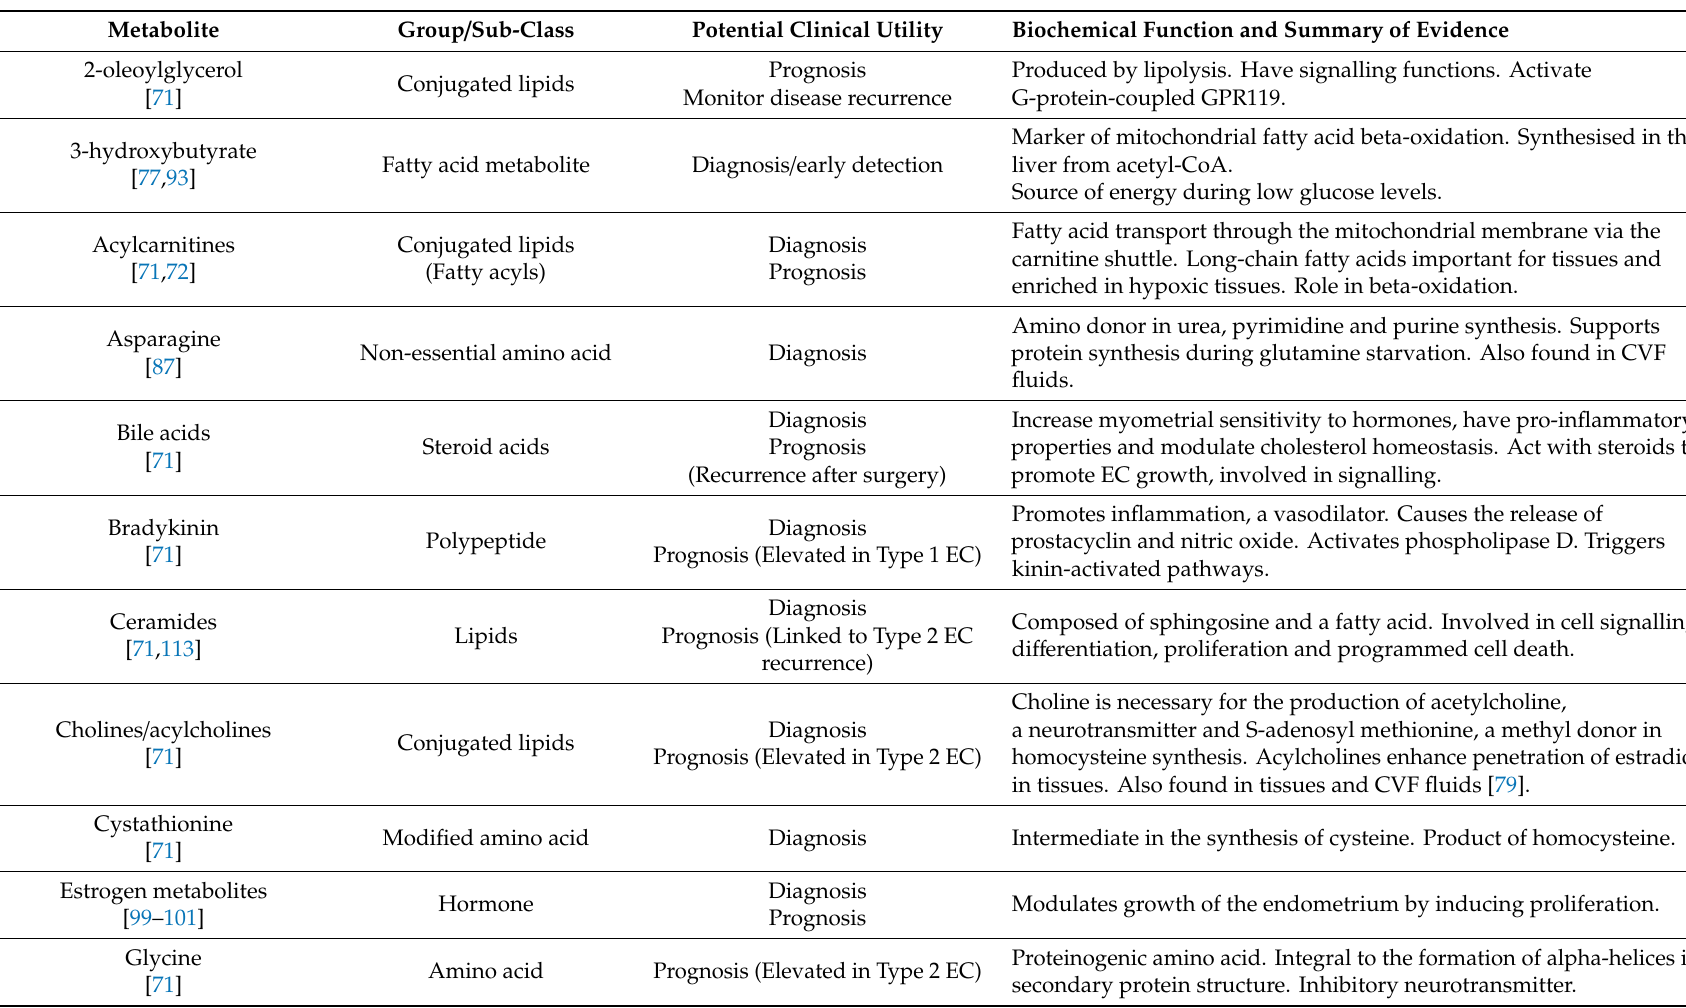
Table 1. Most promising blood-based EC metabolomic biomarker candidates and their